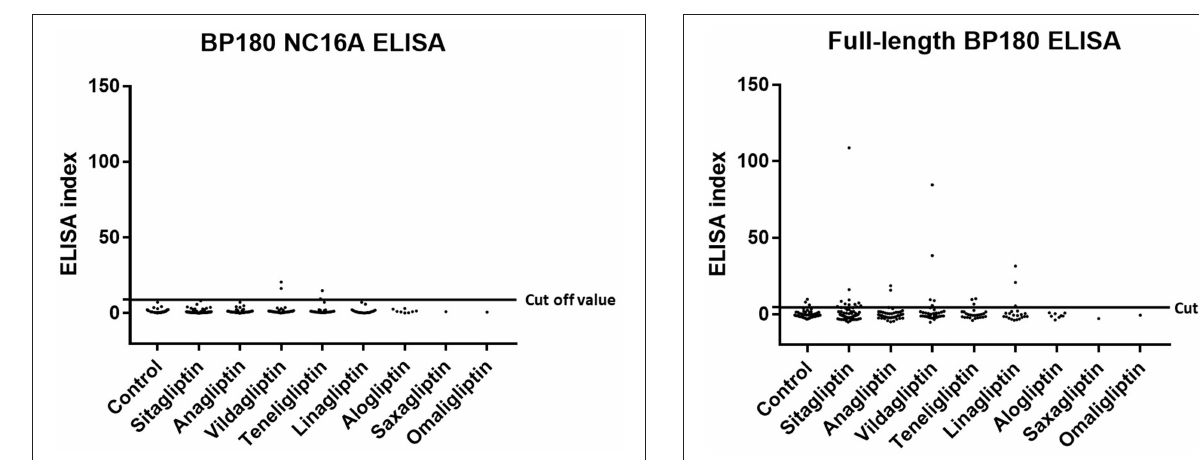
FIGURE 1 | Type 2 diabetes mellitus. Scatter plot of BP180 NC16A ELISA index in DPP-4i (–) and DPP-4i ( + ). Cut-off value of BP180 NC16A ELISA < 9.0, Control indicates the DPP-4i (–) group.